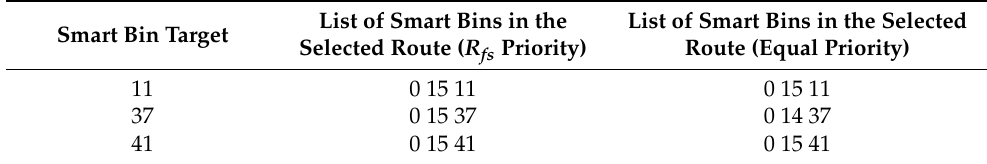
Table 2. Efficient route selected.